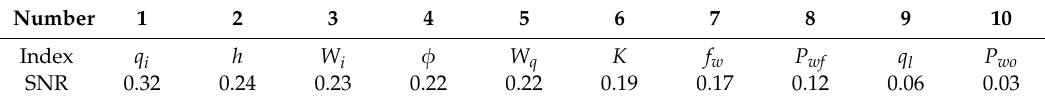
Table 2. Indices ranking results of signal-to-noise ratio (SNR).